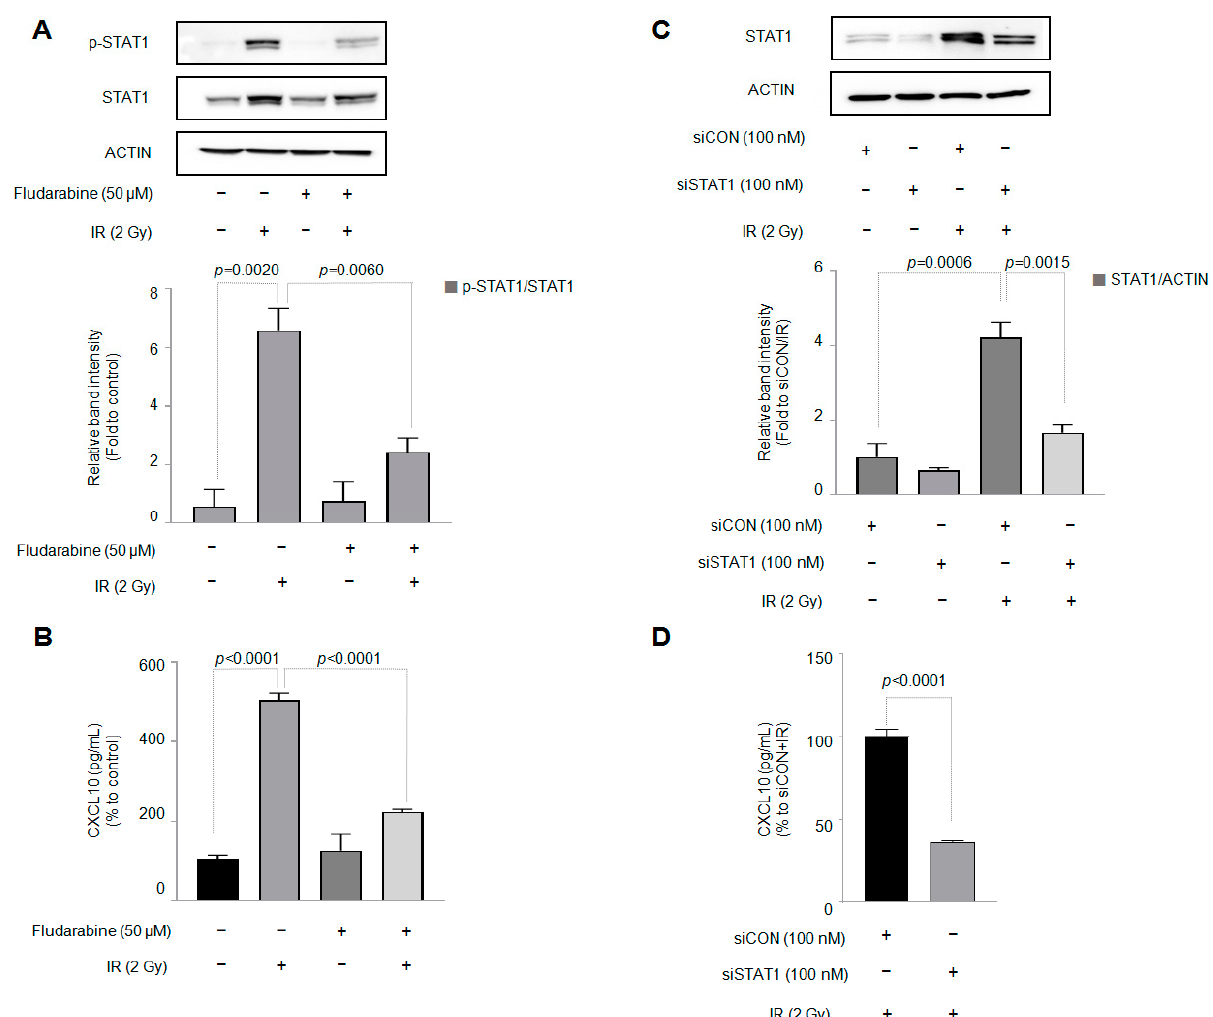
Figure 3. Activation of the signal transducer and activator of transcription 1 (STAT1) protein by ionizing radiation is involved in the production of CXCL10 in J774A.1 macrophages. A total of 2 × 10 5 cells/mL of the J774A.1 macrophage cell line, with or without the STAT1 inhibitor fludarabine (50 µM), was exposed to 2 Gy of radiation. Forty-eight hours later, ( A ) the total STAT1 and phosphorylated STAT1 protein expression and ( B ) the amount of CXCL10 released into the cell culture medium were measured. Fludarabine (50 µM) was treated 30 minutes before the cells were exposed to radiation (n = 3). ( C ) After knocking down the STAT1 gene in J774A.1 macrophages, using the siRNA technique, the production of CXCL10 was confirmed (n = 3). ( D ) The knockdown efficiency of STAT1 was validated (n = 3). Bar graphs are presented as the mean ± standard error of the mean value.